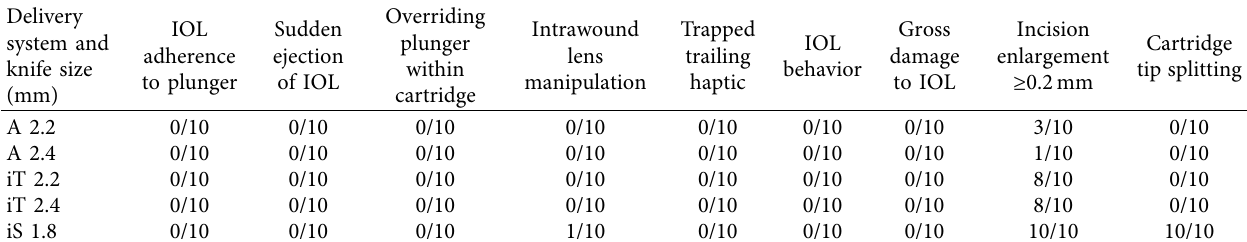
Table 3: Occurrence of IOL delivery system interactions for sclerocorneal incisions.